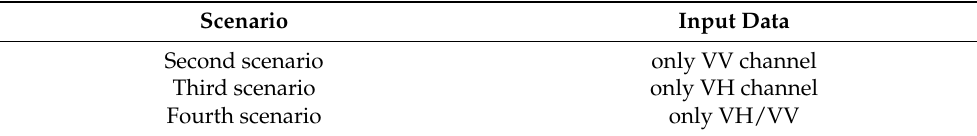
Table 1. Input data of the scenarios of the first approach.